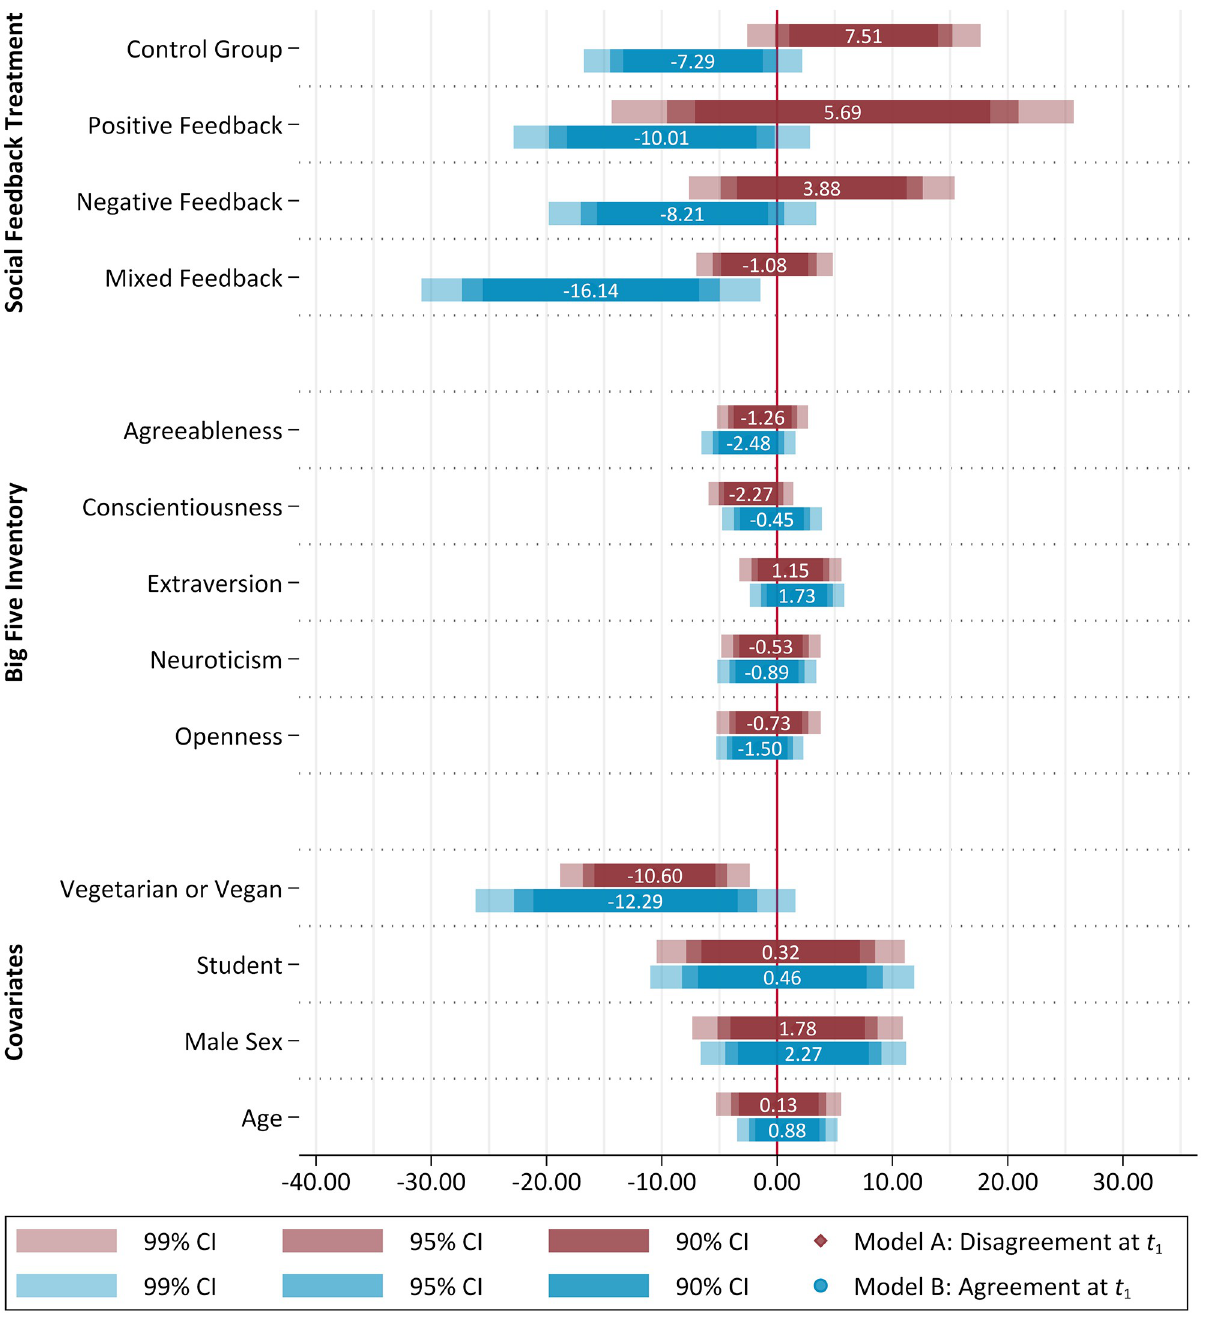
Fig 5. Coefficients plot of the multiple three-level linear mixed-effects regression. S OURCE : ODSF2018 (https://doi.org/10.6084/m9.figshare. 16595378.v1), own calculations. N OTES : N observations = 458, N subjects = 229, N sessions = 19. BFI-10 indices and age are included as z-transformed variables, intercepts are omitted. The graph was generated using the coefplot package for Stata [34]. in the positive feedback group ( SD = 28.39, 95% CI [18.35, 43.92]) and lowest in the mixed feedback group ( SD = 10.08, 95% CI [5.16, 19.71]), things turn out the other way around in model B, in which we estimate SD = 20.72 (95% CI [13.79, 31.13]) for the former and SD = 29.14 (95% CI [21.57, 39.37]) for the latter.